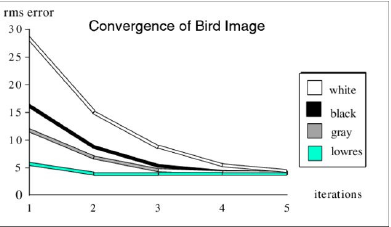
Figure 34. Convergence speed for various seed images. Reprinted with permission from [47]. Copy- right 1997